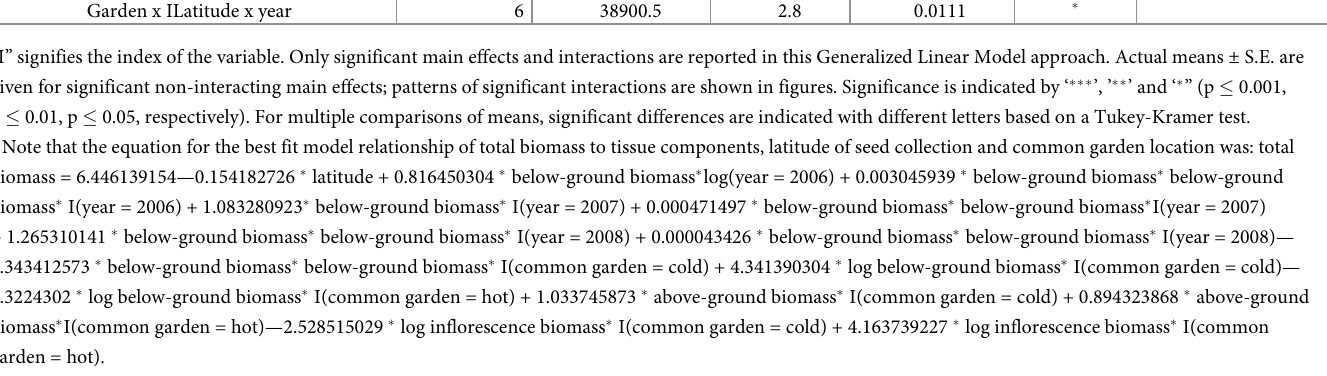
Table), although this variable was not significant in the PROC GLM Select analysis (p > 0.15). Total biomass varied in a non-linear fashion as a function of garden type, latitude of seed collection and year (F = 2.8, p = 0.0111; Table 2D). Also note that the plants were not likely to have been pot-bound at the end of the study because the root biomass increased by 3.4 x between the 2 nd and the 3 rd year (mean root biomass in 2006, 2007 and 2008: 12.9 ± 0.9 g, 81.9 ± 4.5 g, and 278.2 ± 11.5 g pot -1 , respectively). Reaction norms were constructed using progeny from the same maternal plants [60] com- pared between common garden environments in T ř ebo ň vs. Lafayette (cold vs. hot garden; Figs 2 and 3). Note that GLM Select did not find significant differences in overall response among mother plants within populations (Table 2A–2D; p > 0.05). Broadly comparing log total biomass, individuals grown from the seeds of mother plants from Turkey, Spain and Ten- nessee had a wide variation in response when grown in T ř ebo ň vs. Lafayette (F = 6.0, 2.5 and